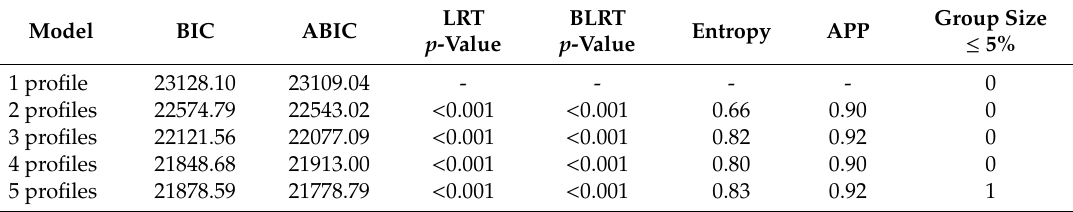
Table 2. Values for di ff erent model parameterizations ( n =